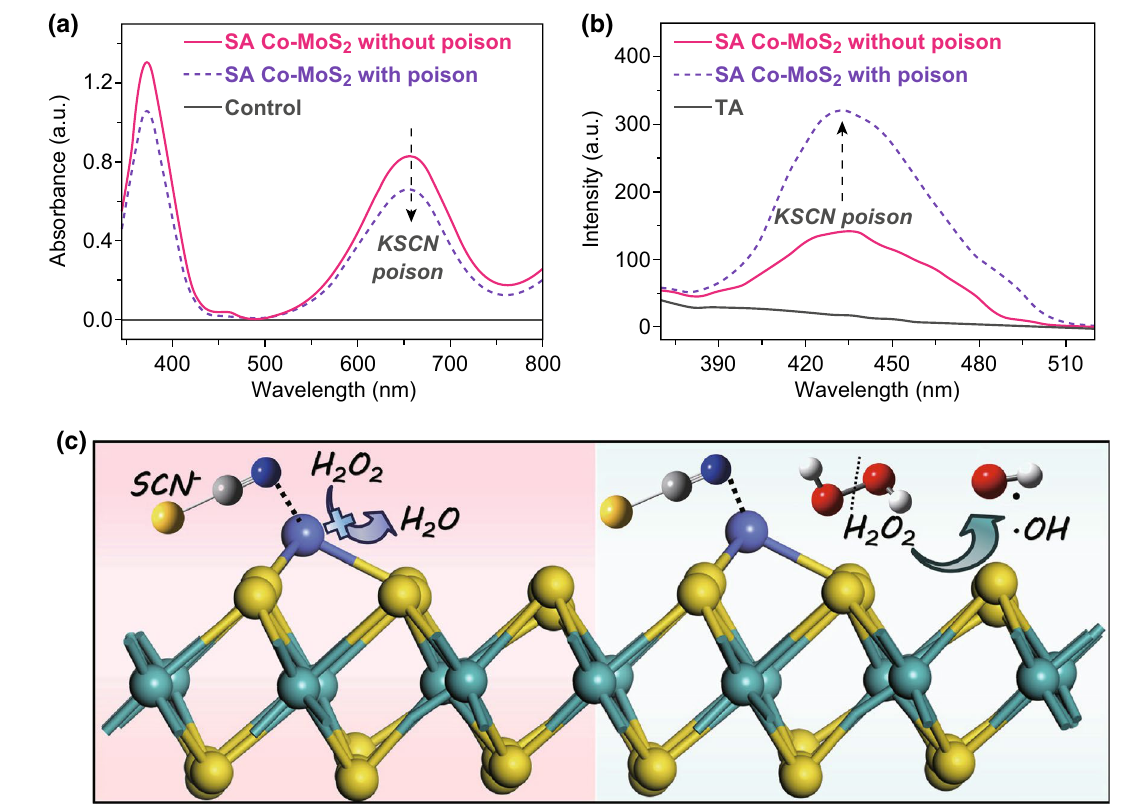
Fig. 3 Changes in the a UV–Vis spectrum and b fluorescence spectrum when SA Co–MoS 2 was poisoned with 10 mM KSCN. c The corre‑ sponding illustration of the poison’s influences. Red spheres: O; gray spheres: C; white spheres: H; light‑blue spheres: N. (Color figure